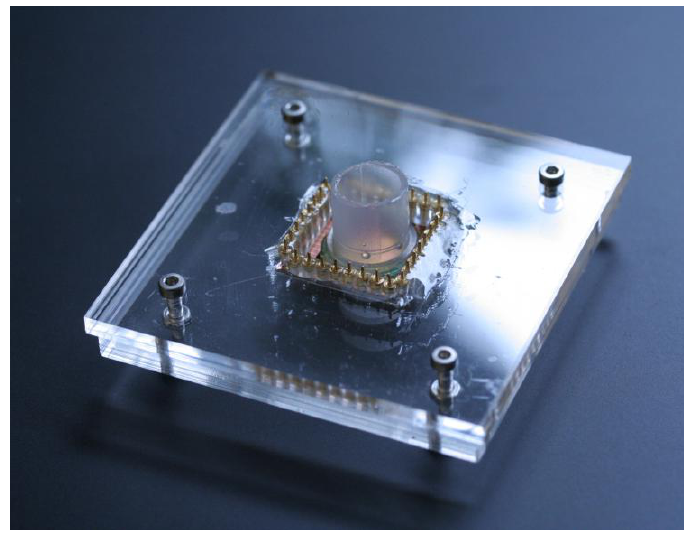
Figure 5. PMMA holder used for electrochemical